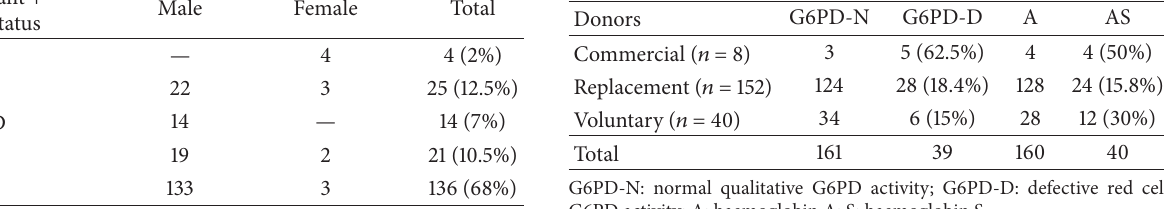
Table 1: Age and gender distribution of blood donors. Hb variant +